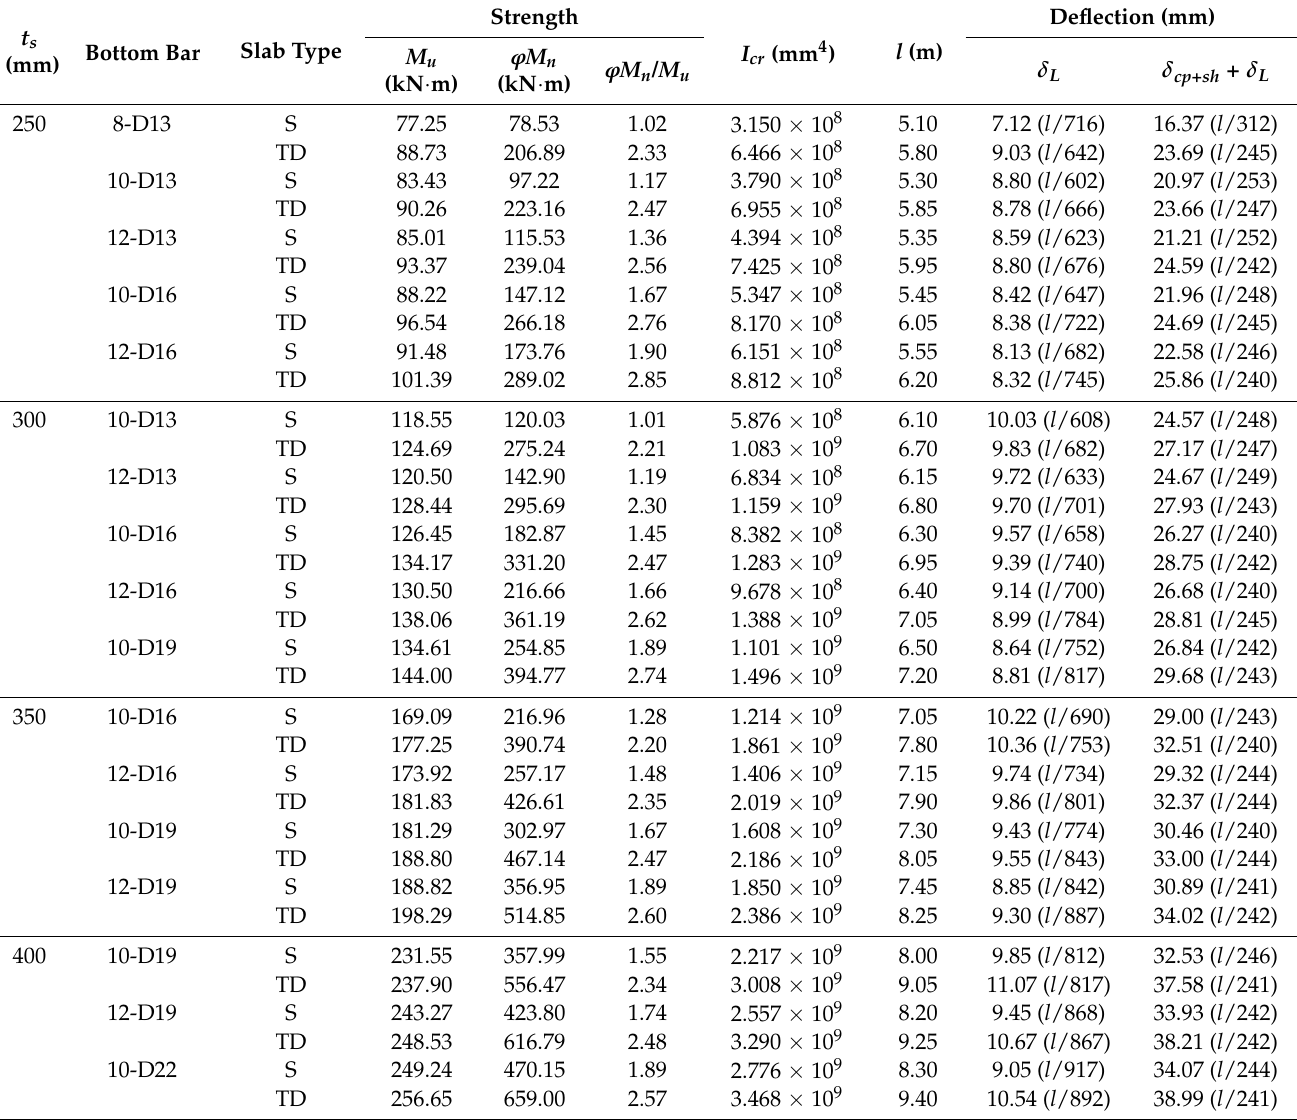
Table 7. Deflection comparison of TD slabs and S slabs with the same tension reinforcing